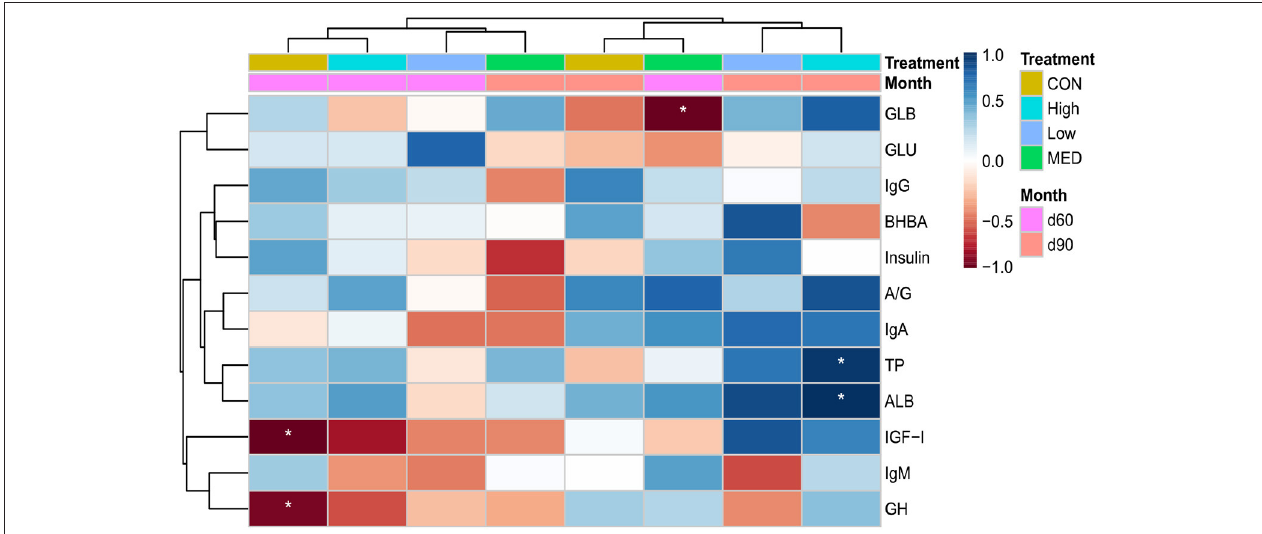
FIGURE 2 | A heatmap illustrating Pearson’s correlation between body weight and blood parameters of goat kids supplemented with different concentrations of BHBA. Significance levels: * p < 0.05. The control group was fed without dietary supplementation; and the low-, medium-, and high-dose groups were fed with 2, 6, and 9 g/animal/day of BHBA, respectively. BHBA, beta-hydroxybutyric